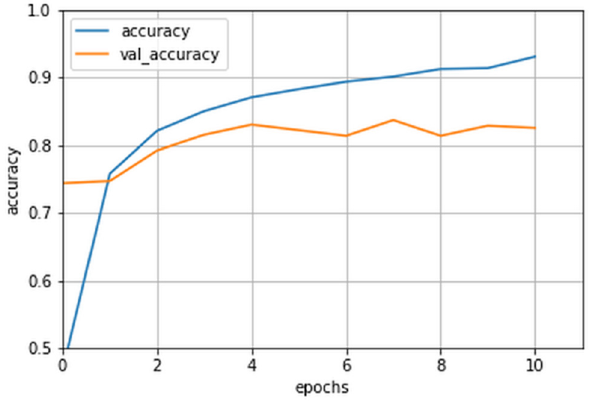
Figure 3. Training and validation set accuracy over epochs (Exp1).